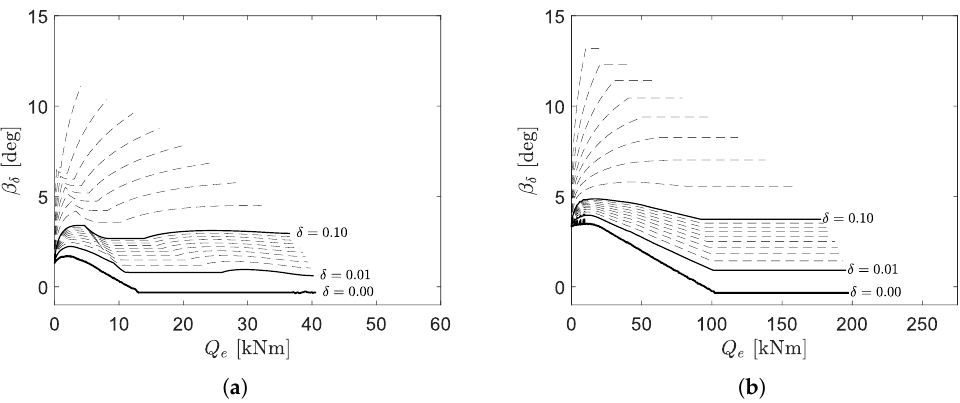
Figure 10. β δ ( Q e , δ ) tables for NREL 5-MW ( a ) and DTU 10-MW ( b ) reference